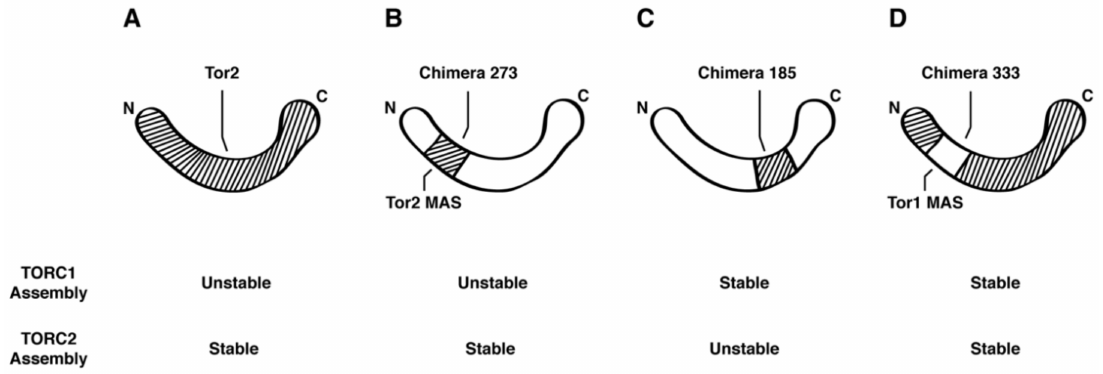
Figure 8. Model depicting the role of the Tor1 and Tor2 MAS domains in contributing to the complex specificity of TORC1 and TORC2 assembly. Stripped lines refer to Tor2 sequences, while the non-stripped diagram depicts Tor1